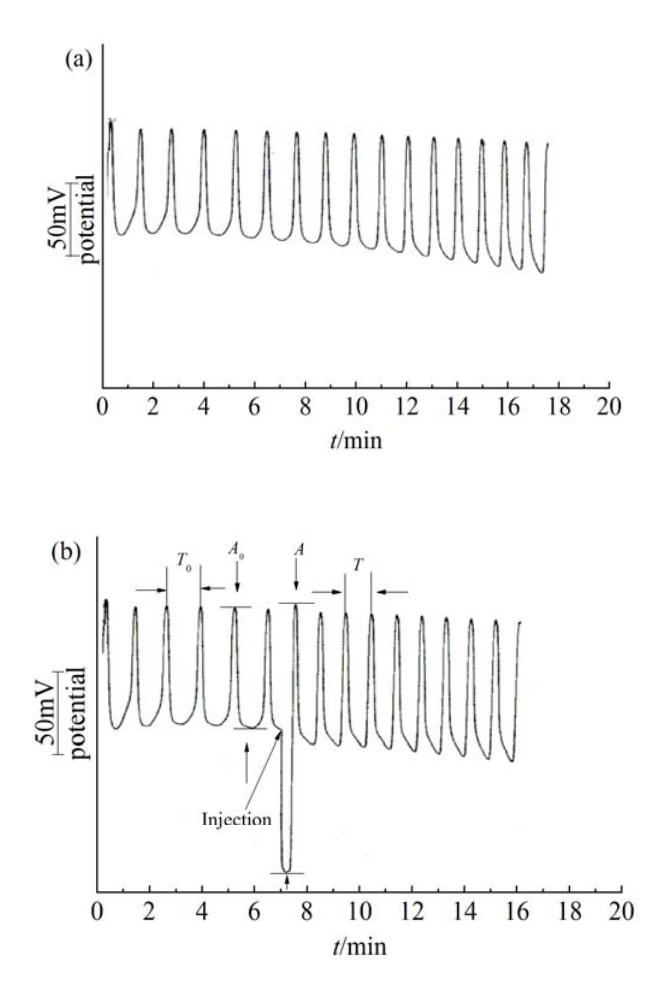
Figure 1 Typical oscillating profiles for the proposed oscillation system in the absence and presence of 1.25×10 -5 M paracetamol perturbation using platinum electrode: (a) [paracetamol] = 0.000 M (b) [paracetamol] = 1.88×10 -5 M. Common conditions: [NaBrO 1.875×10 -2 M; [malic acid] = 0.20 M: [H